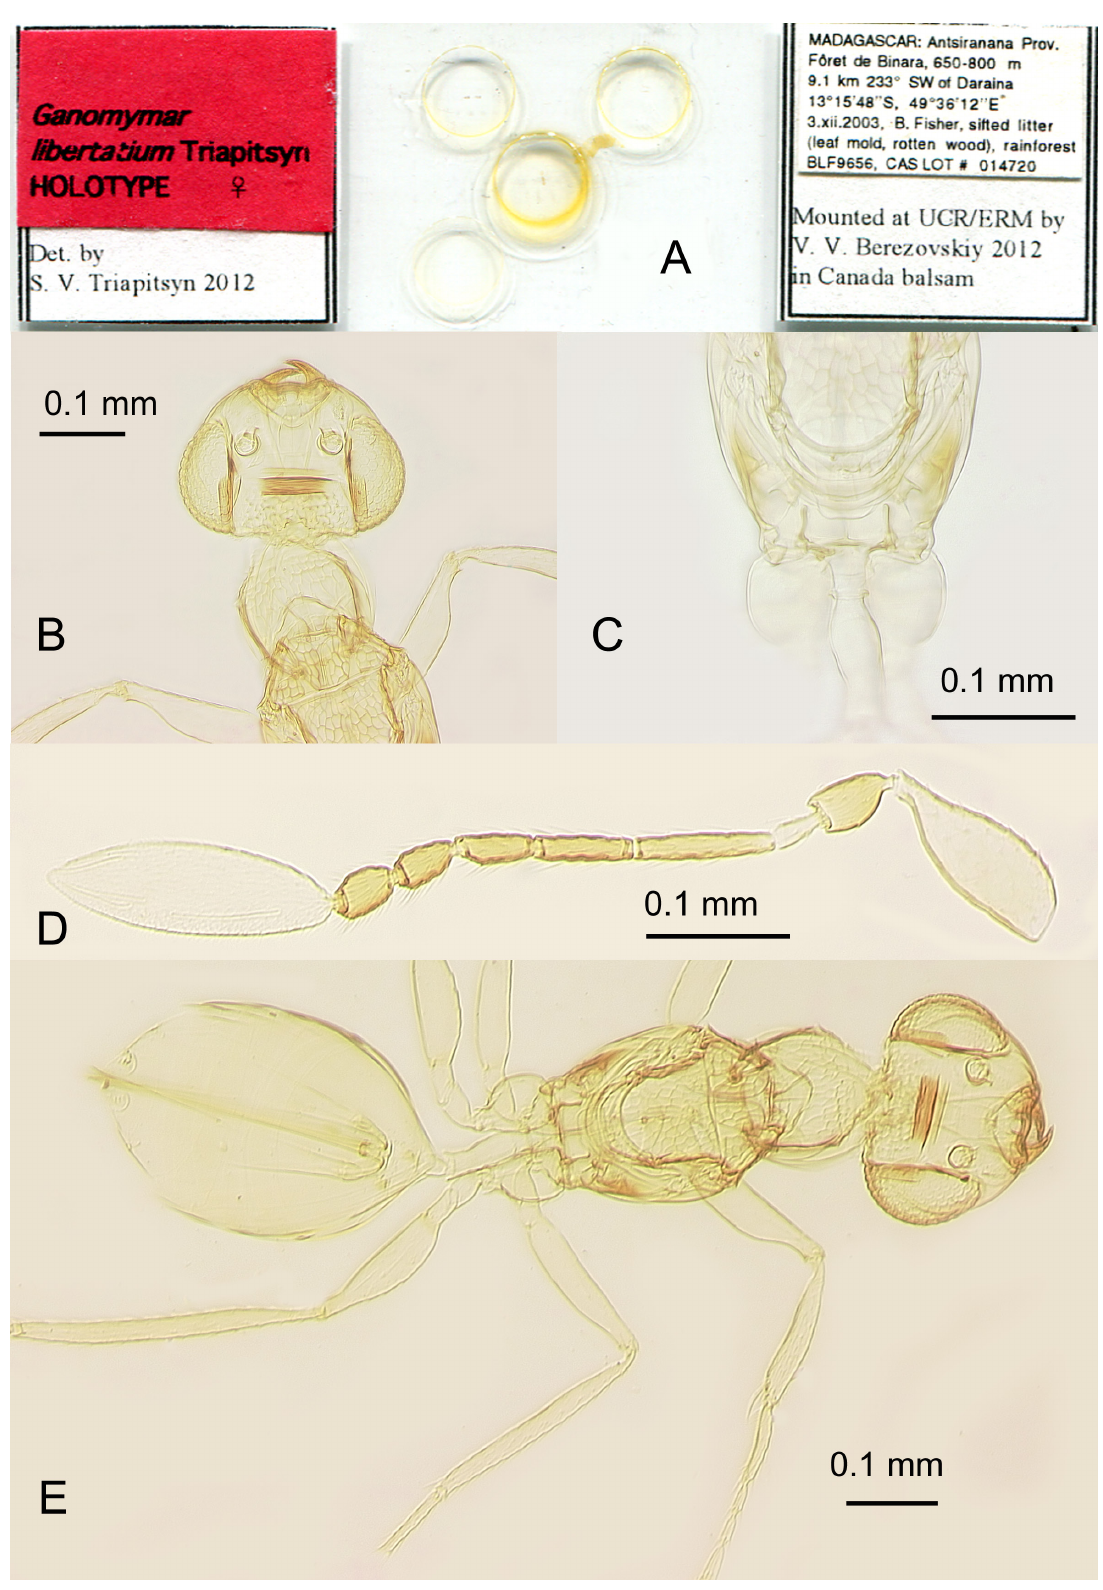
Fig. 8. Ganomymar libertatium sp. nov., ♀, holotype (CAS). A . Slide. B . Head, pronotum and mesoscutum. C . Scutellum, propodeum and petiole. D . Antenna. E .